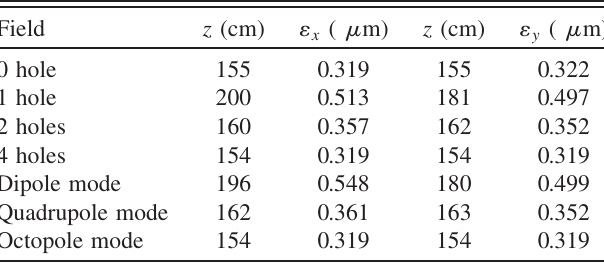
TABLE IV. Minimum emittance for 0.1 nC charge.